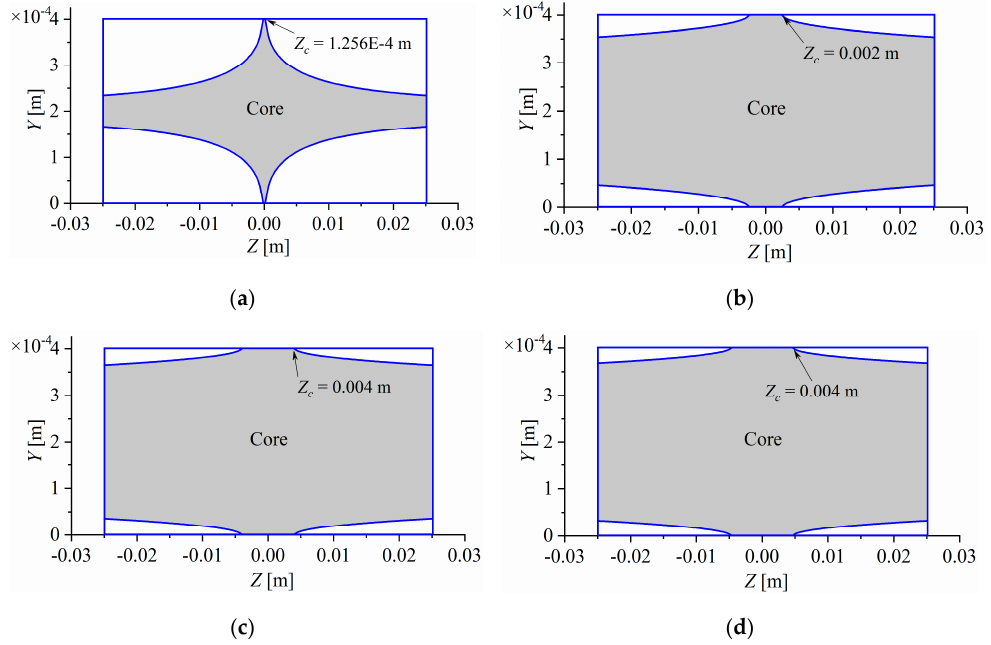
Figure 6. Positions of yield surface in MRD under several currents. ( a ) I = 0.03 A, ( b ) I = 0.5 A, ( c ) I = 1 A, ( d ) I = 1.5 A.